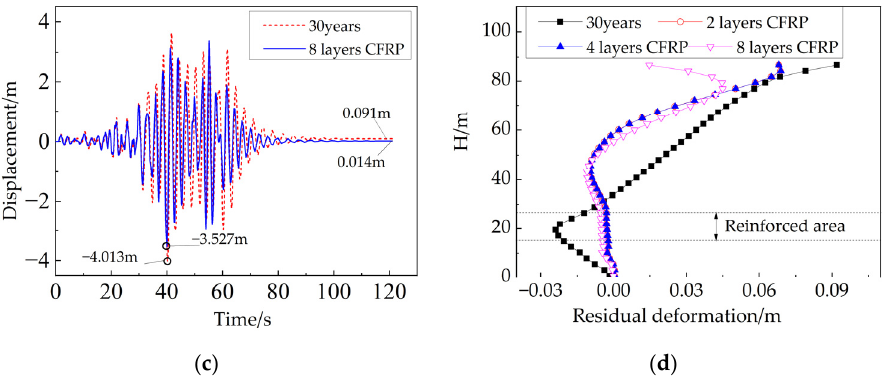
Figure 20. Comparison of different reinforcement conditions: ( a ) two-layer CFRP reinforcement; ( b ) four-layer CFRP reinforcement; ( c ) eight-layer CFRP reinforcement; ( d ) Comparison of structural residual deformation.